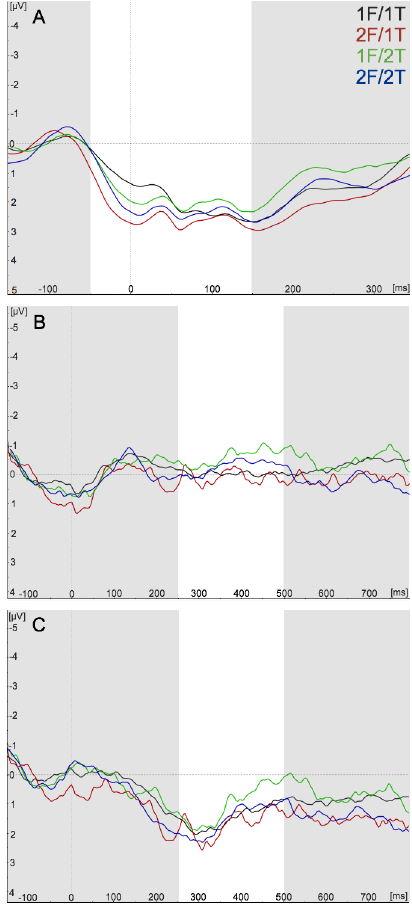
Figure 6. The correct response-related negativity (CRN) and error-related positivity (Pe) did not respond to the manipula- tion of the representation of response alternatives. Response alternatives were defined by the number of fingers represented in the target and flanker: one-finger flanker (1F) and one-finger target (1T), or two-finger flanker (2F) and two-finger target (2T). ( A ) Grand-average raw correct waveforms from 2 150 to 350 ms locked to the response in the incongruent condition at the FCz ROI. ( B ) The raw error waveforms from 2 150 to 800 ms locked to the response in the incongruent condition at the Pz ROI. ( C ) Grand-average error-correct difference waveforms from 2 150 to 800 ms locked to the response in the incongruent condition at the Pz ROI. Highlighted timeframe on grand- averaged waveforms represents the window used for detecting the peak amplitude of the CRN, and the mean voltage of the